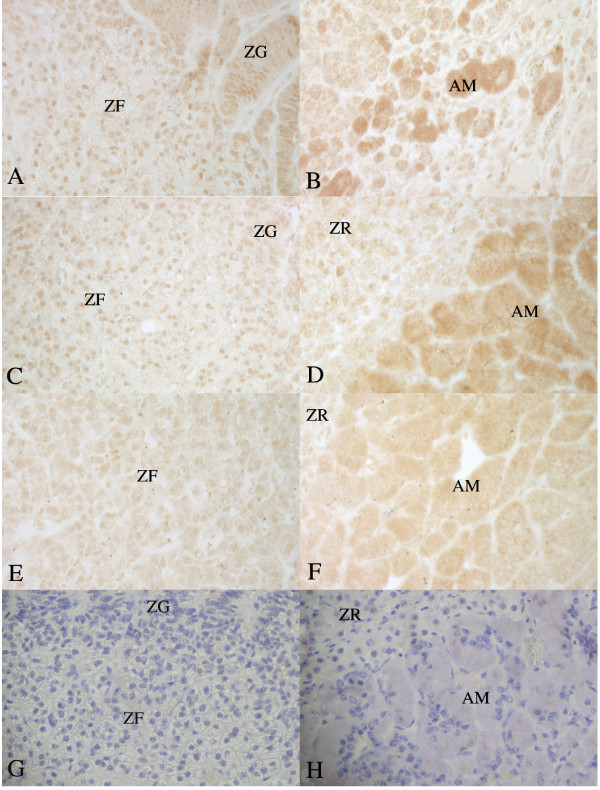
Immunostaining for ERα and PR in adrenal tissue. A and B: ERα in mare 744 (OVX); C and D: ERα in mare 502 (intact in dioestrus); E and F: PR in mare 744 (OVX); G and H: negative control. ZG = Zona glomerulosa; ZF = Zona fasciculata; ZR = Zona reticularis and AM = adrenal medulla. Magnification 200×.